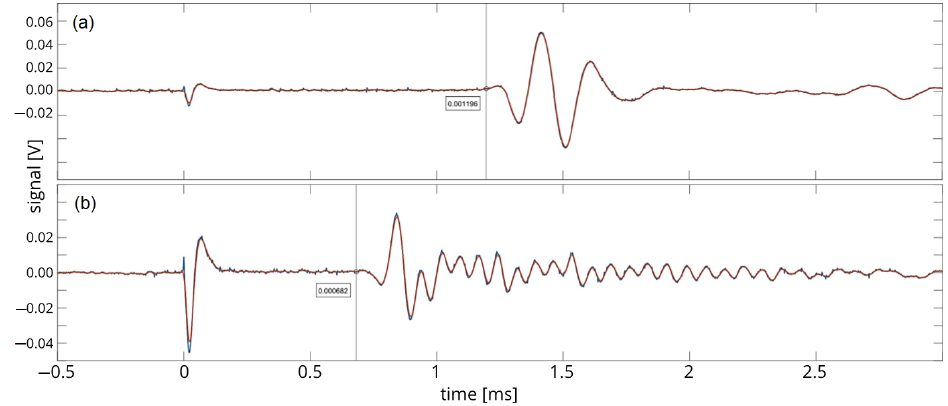
Figure 6. Examples for ultrasound measurement records with (a) 2000 N and (b) 2500 N loading.